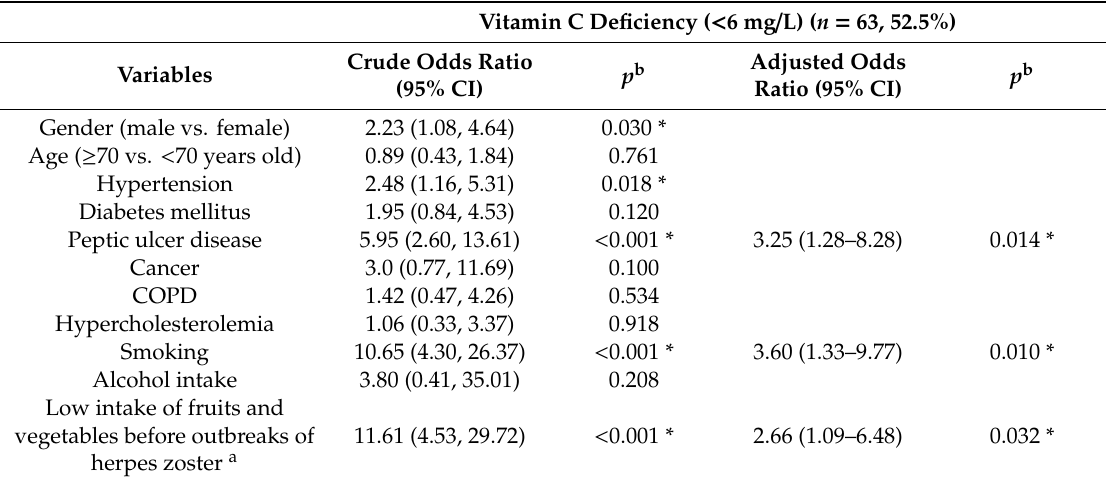
Table 5. Multivariate logistic analysis for plasma vitamin C deficiency in 120 PHN